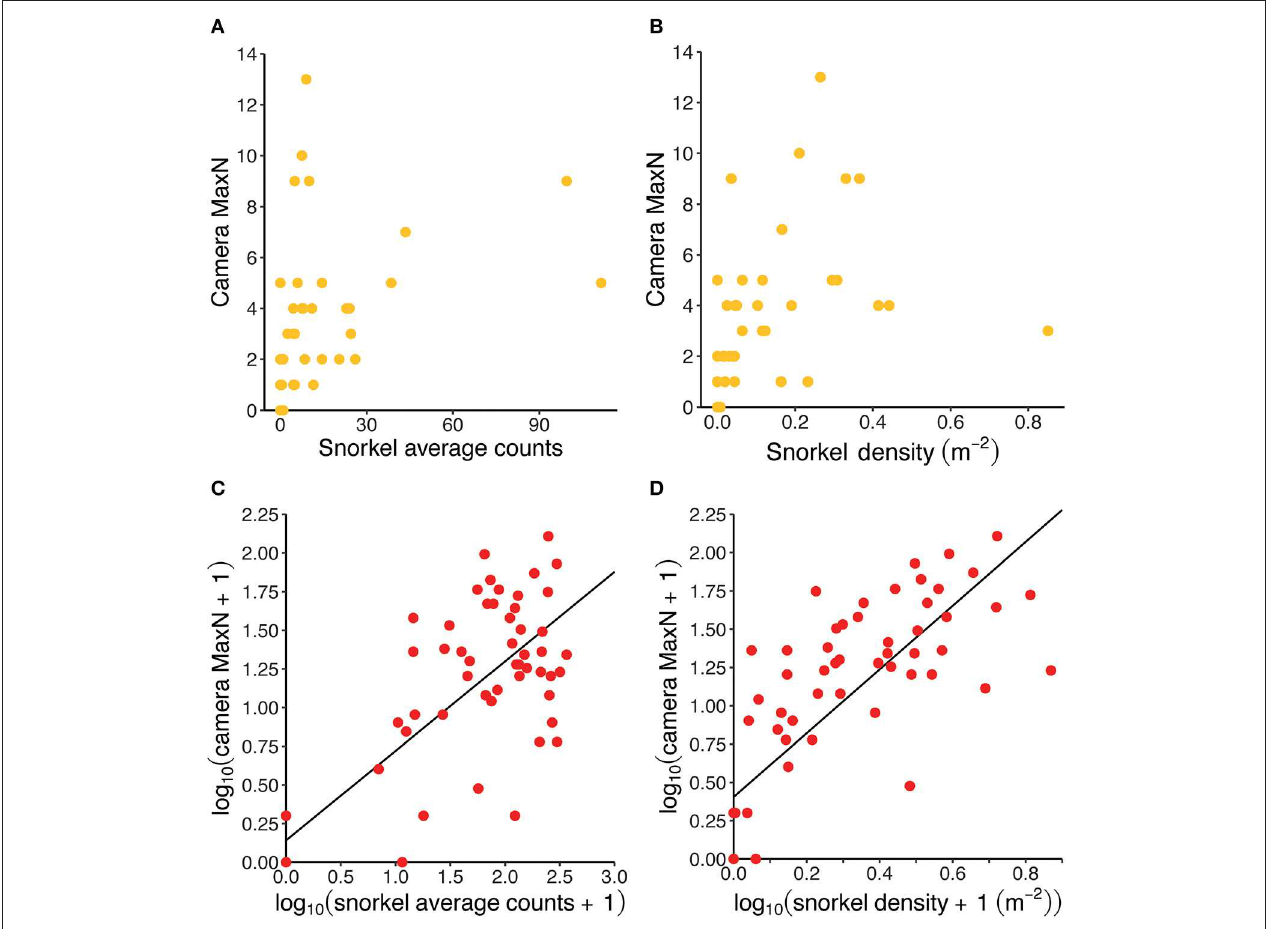
FIGURE 5 | Visualizing the positive correlation between camera and snorkel abundance estimates for Cape Kurper (yellow) and redfins (red): (A) MaxN vs. snorkel average counts for Cape Kurper; (B) MaxN vs. snorkel density for Cape Kurper; (C) log-transformed MaxN vs. log-transformed snorkel average counts for redfins, regression line intercept = 0.14131 (SE = 0.09362) and slope = 0.57897 (SD = 0.05454), r 2 = 0.65, p < 0.001; and (D) log-transformed MaxN vs. log-transformed snorkel density for redfins, regression line intercept = 0.4050 (SE = 0.0770) and slope = 2.0806 (SE = 0.2067), r 2 = 0.62, p <